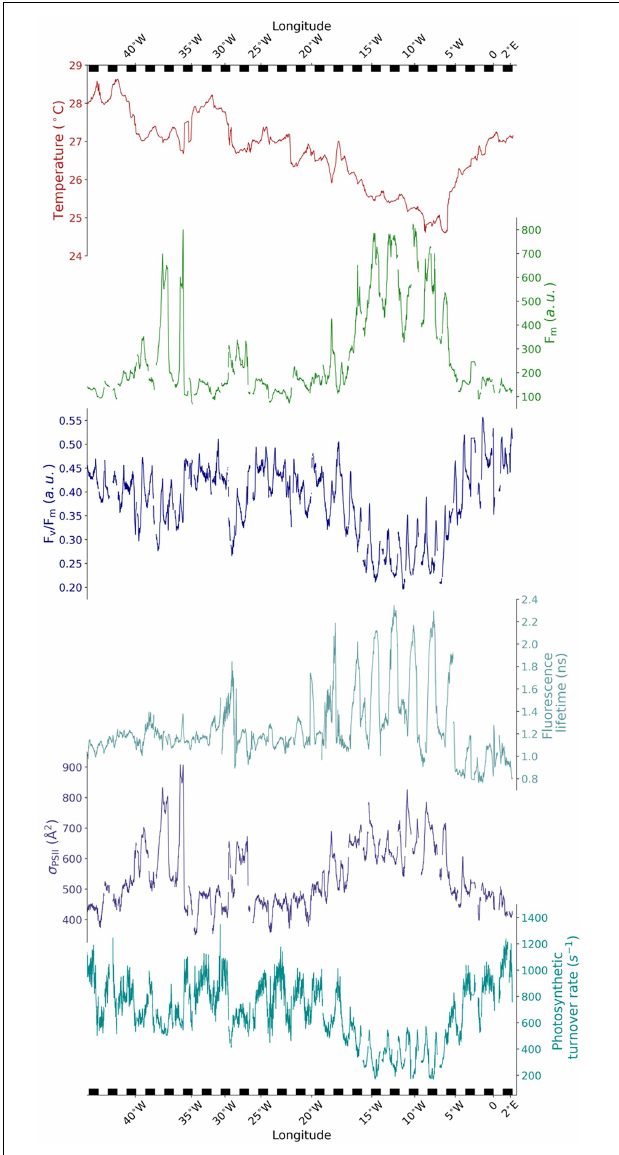
FIGURE 3 | Time series of near-surface temperature and photophysiology derived along the Equator. Photophysiological data from underway FIRe and PicoLiF, representing low-light acclimated phytoplankton. Temperature is measured by the ship thermosalinograph. From top to bottom; sea surface temperature (red), F m (green), F v /F m (blue), fluorescence lifetime (cyan), σ PSII (dark blue), and photosynthetic turnover rate (dark cyan). Note the top and bottom x -axis ticks reflect the longitude in order to easily locate the steady-state sections and the upwelling events. The black and white bars at top and bottom denote night and day, highlighting the temporal variability of the data. Each series was smoothed using a rolling mean (30-min window).